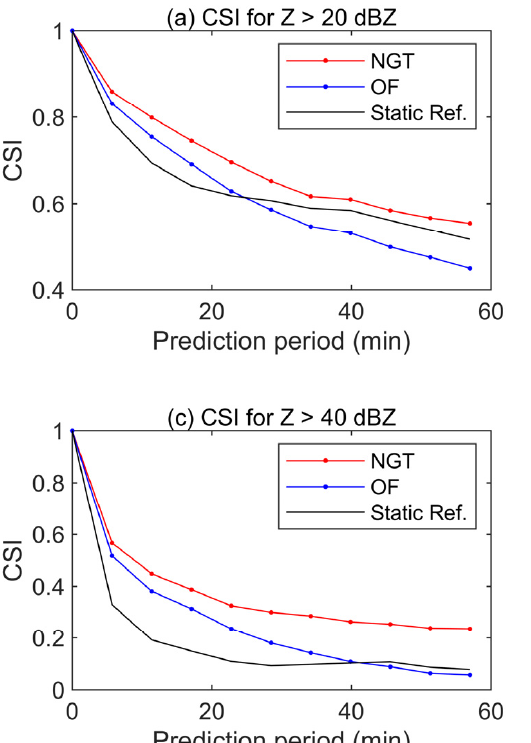
Figure 10. Fifty ‐ seven ‐ minute prediction results. The target time is 15:22 UTC on 17 May 2020. The shading is the predicted CAPPI at a height of 3 km. The black solid lines are the 30 dBZ contours of the convective echo observed at the target time (Figure 8c). The vector fields are obtained by NGT and OF for backward interpolation. ( a ) NGT; ( b ) OF.